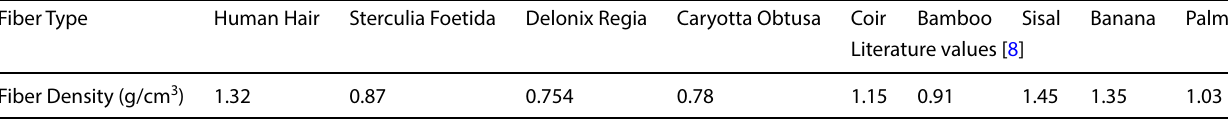
Table 2 Comparison of density of fibers with other natural fibers Fiber Type